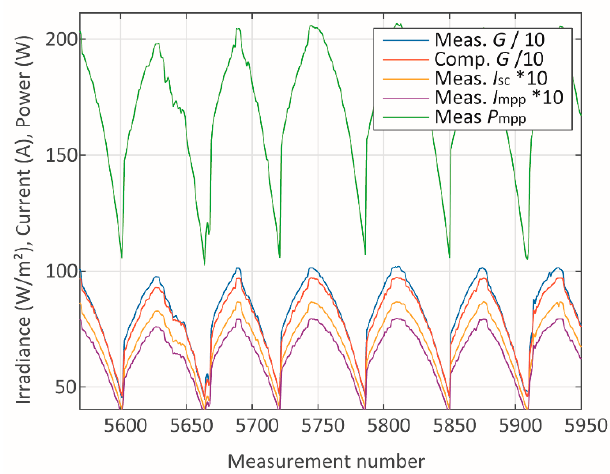
Sensors 2020 , 20 , x FOR PEER REVIEW Figure 5. Irradiance, current, and power during clear-sky days. Figure 5. Irradiance, current, and power during clear-sky days.